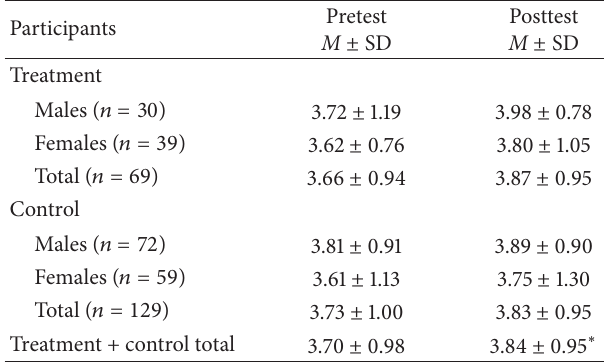
Table 1: Overall pre- and posttest future intent score means.